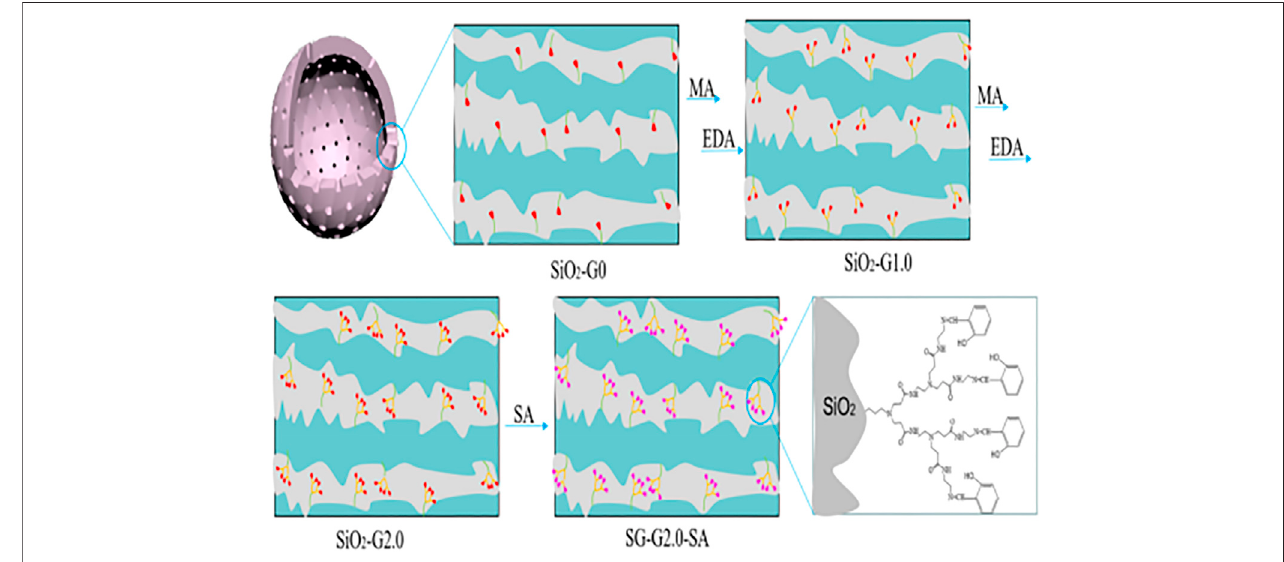
FIGURE 7 | The synthesis route for SG-G2.0-SA.